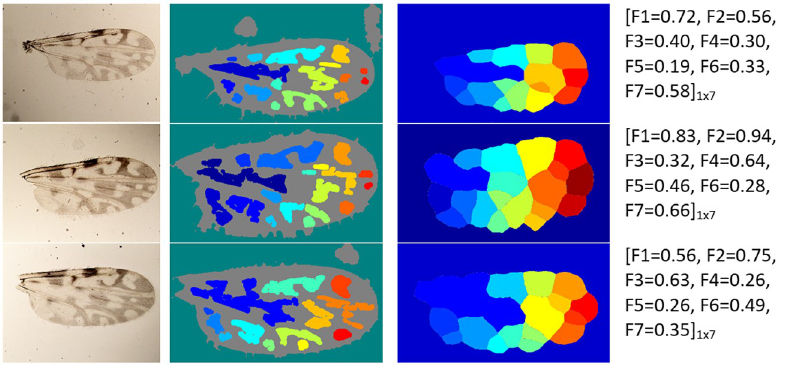
Fig 6. Performance of the proposed method on C. foxi species samples. From left to right column: original wing image, particle detection, segmentation of zones of interest through the watershed method, and the final feature vector output obtained.